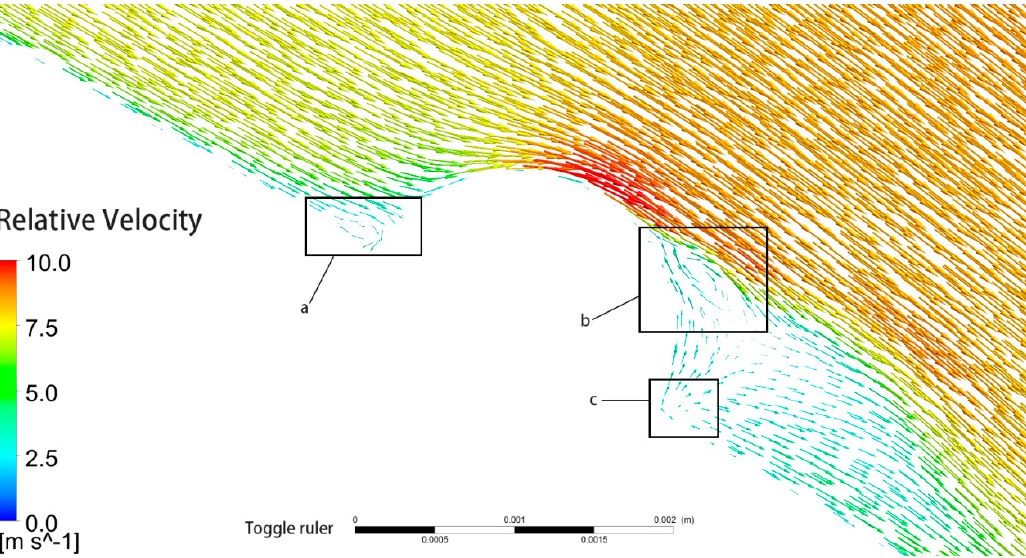
Figure 28. Relative velocity vectors around the blade surface with bionic convex domes at Figure 7a (units: m/s).